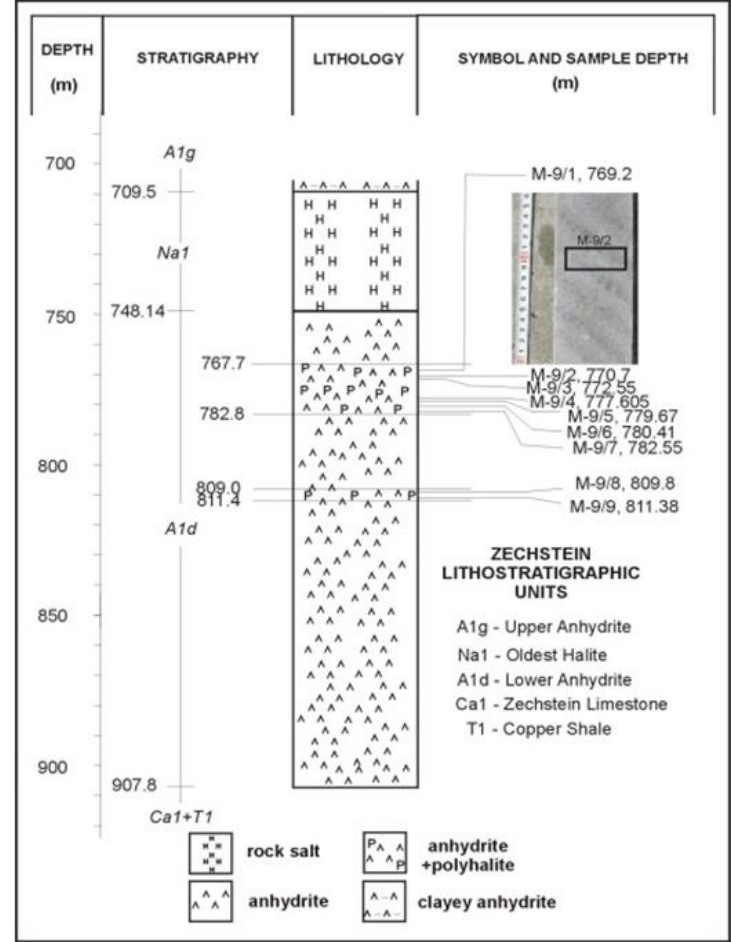
Figure 2. Sampled profile of Mieroszyno M-9 borehole with polyhalite interbeds within the Lower Anhydrite (A1d) unit. M-9/1, 769.2—sample number and depth in metres, in frame—thin section (sample M-9/2) on Figure 11.